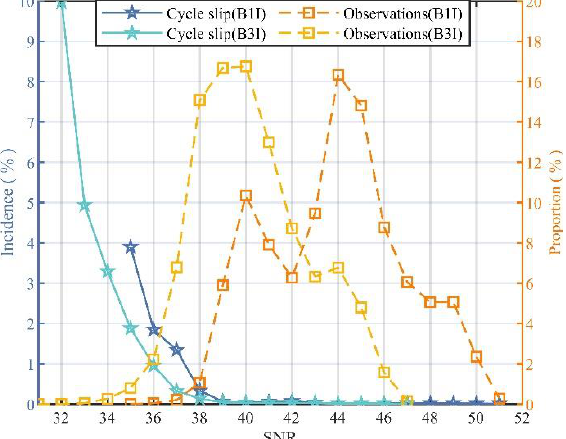
Figure 11. The change trend of cycle-slip frequency and measurement observations with SNR.